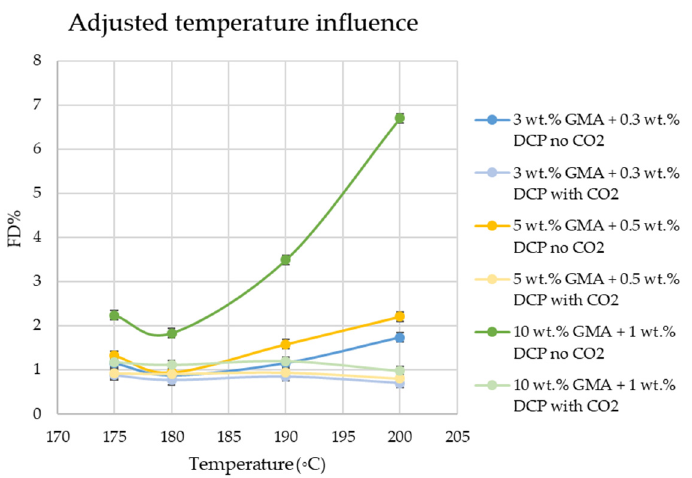
Figure 7. Influence of temperature while using the ideal screw speed for RPE samples.